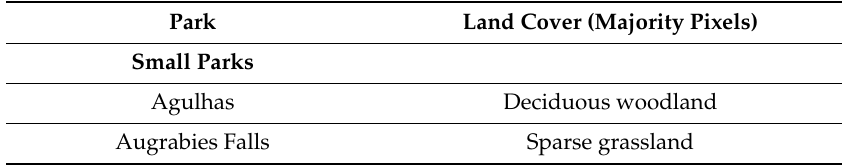
Table A1. This table includes the park names and the land cover table, based on majority of